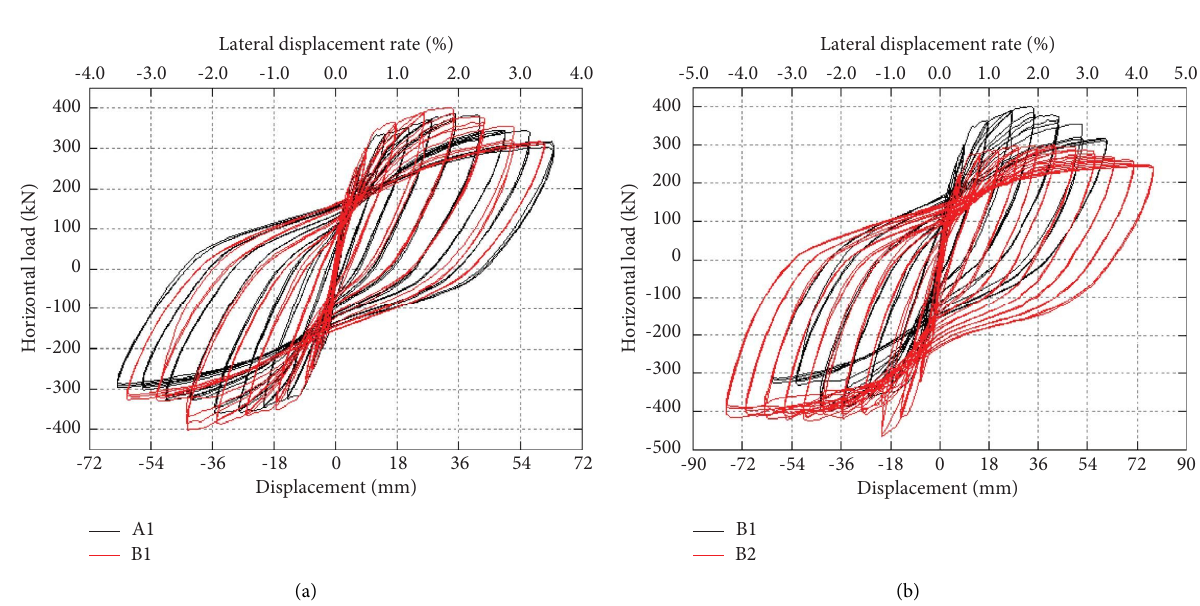
Figure 7: Hysteresis curve of each specimen. (a) Specimens A1 and B1. (b) Specimens B1 and B2.